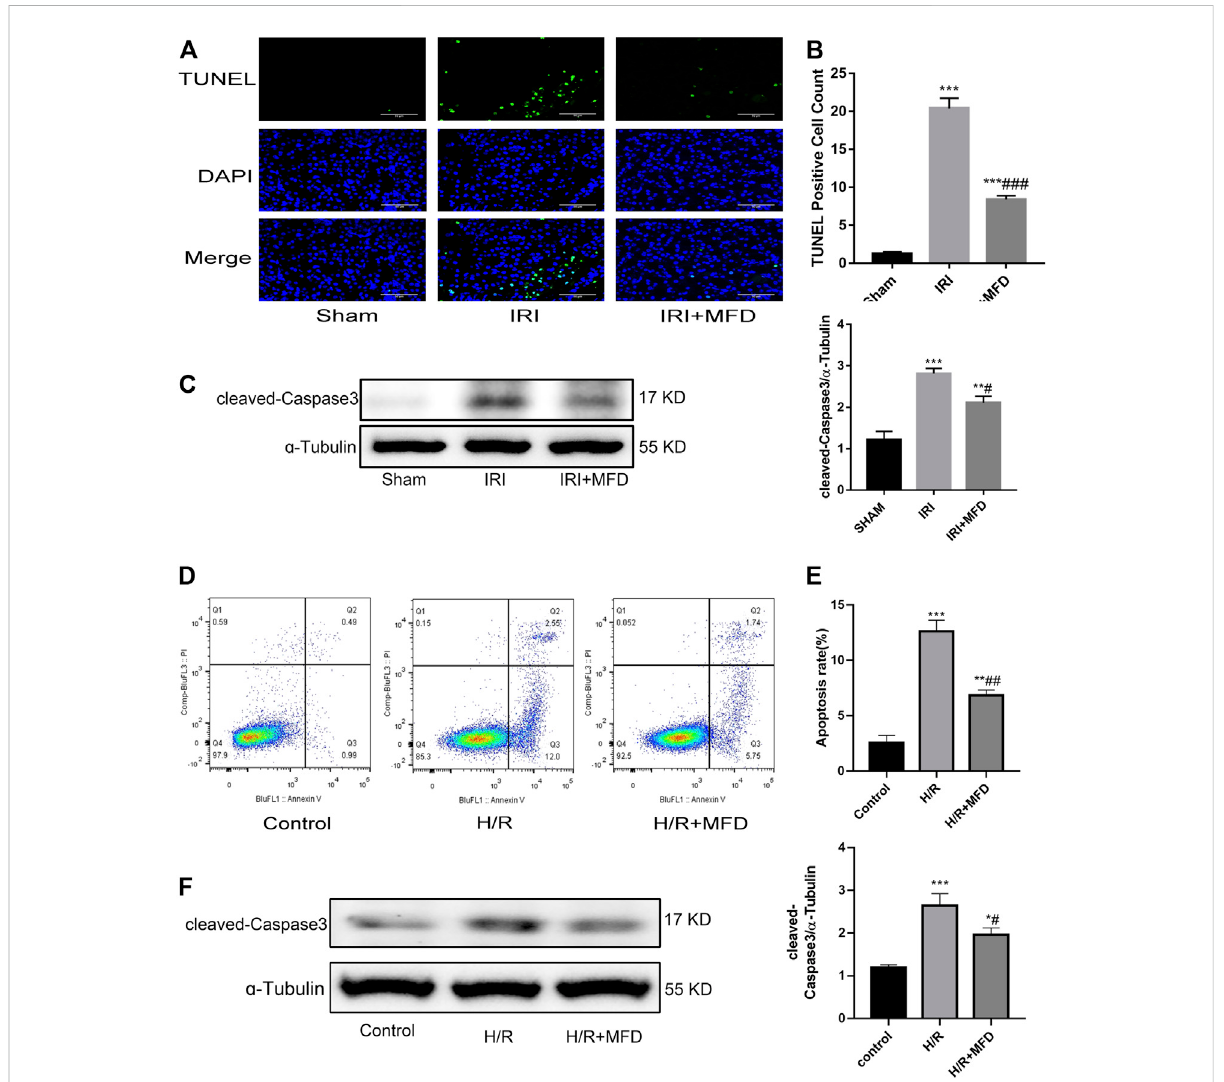
FIGURE 3 Mefunidone abated renal apoptosis (A) TUNEL staining in the renal tissues on day 2 after IRI modeling (×400). (B) Quanti fi cation of TUNEL positivecellcountperscope. (C) Westernblotanalysisandquantitativedataofcleaved-caspase3intherenaltissuesonday2afterIRImodeling. (D,E) Flow cytometry and quantitative comparison were applied to detect apoptosis of HK-2 cells in H/R model with or without mefunidone. (F) Western blot analysis and quantitative data of cleaved-caspase3 in the H/R model of HK-2 cells with or without mefunidone. Dose of mefunidone